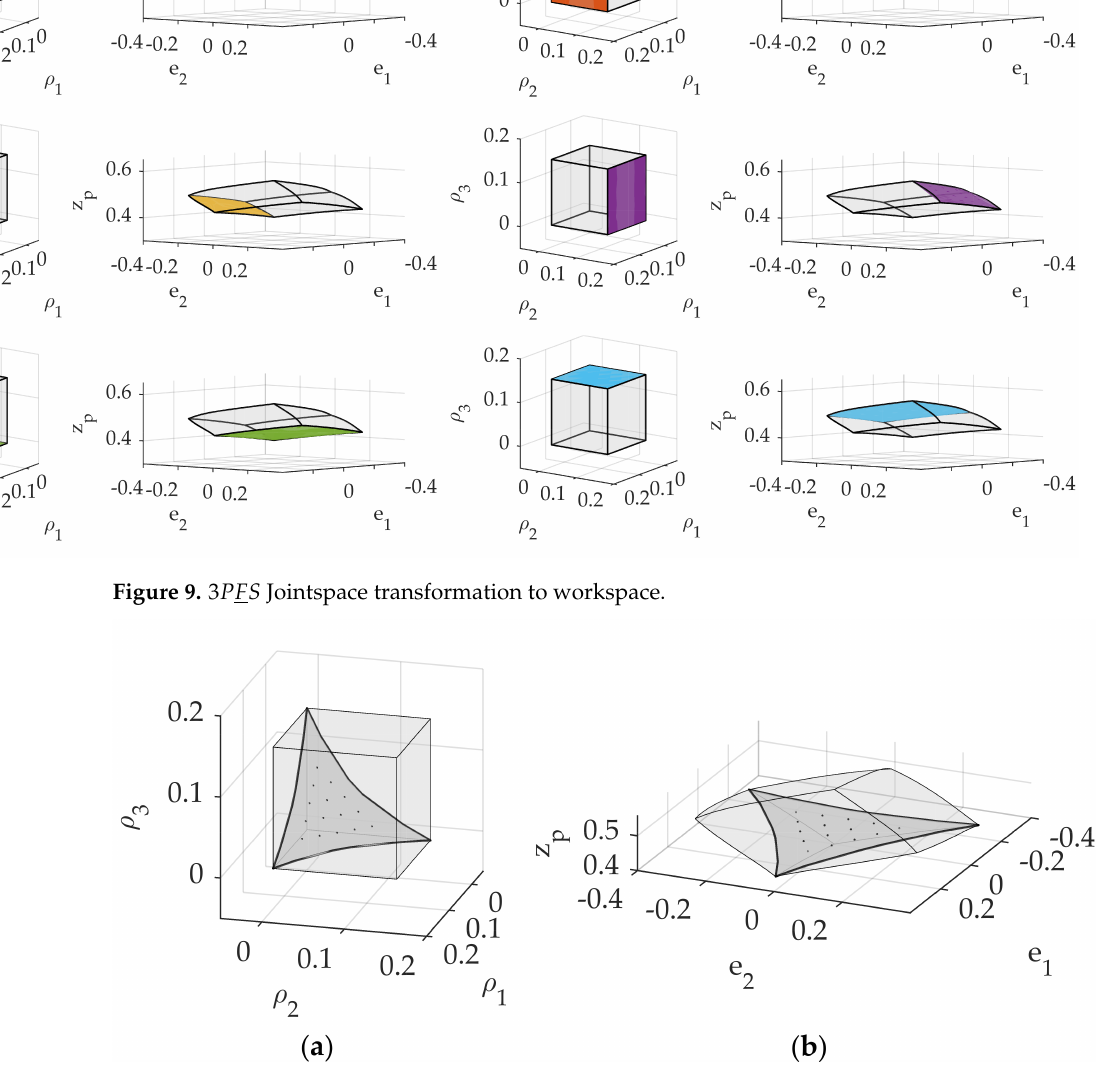
Figure 10. 3 PFS Jointspace transformation to workspace for a constant z P